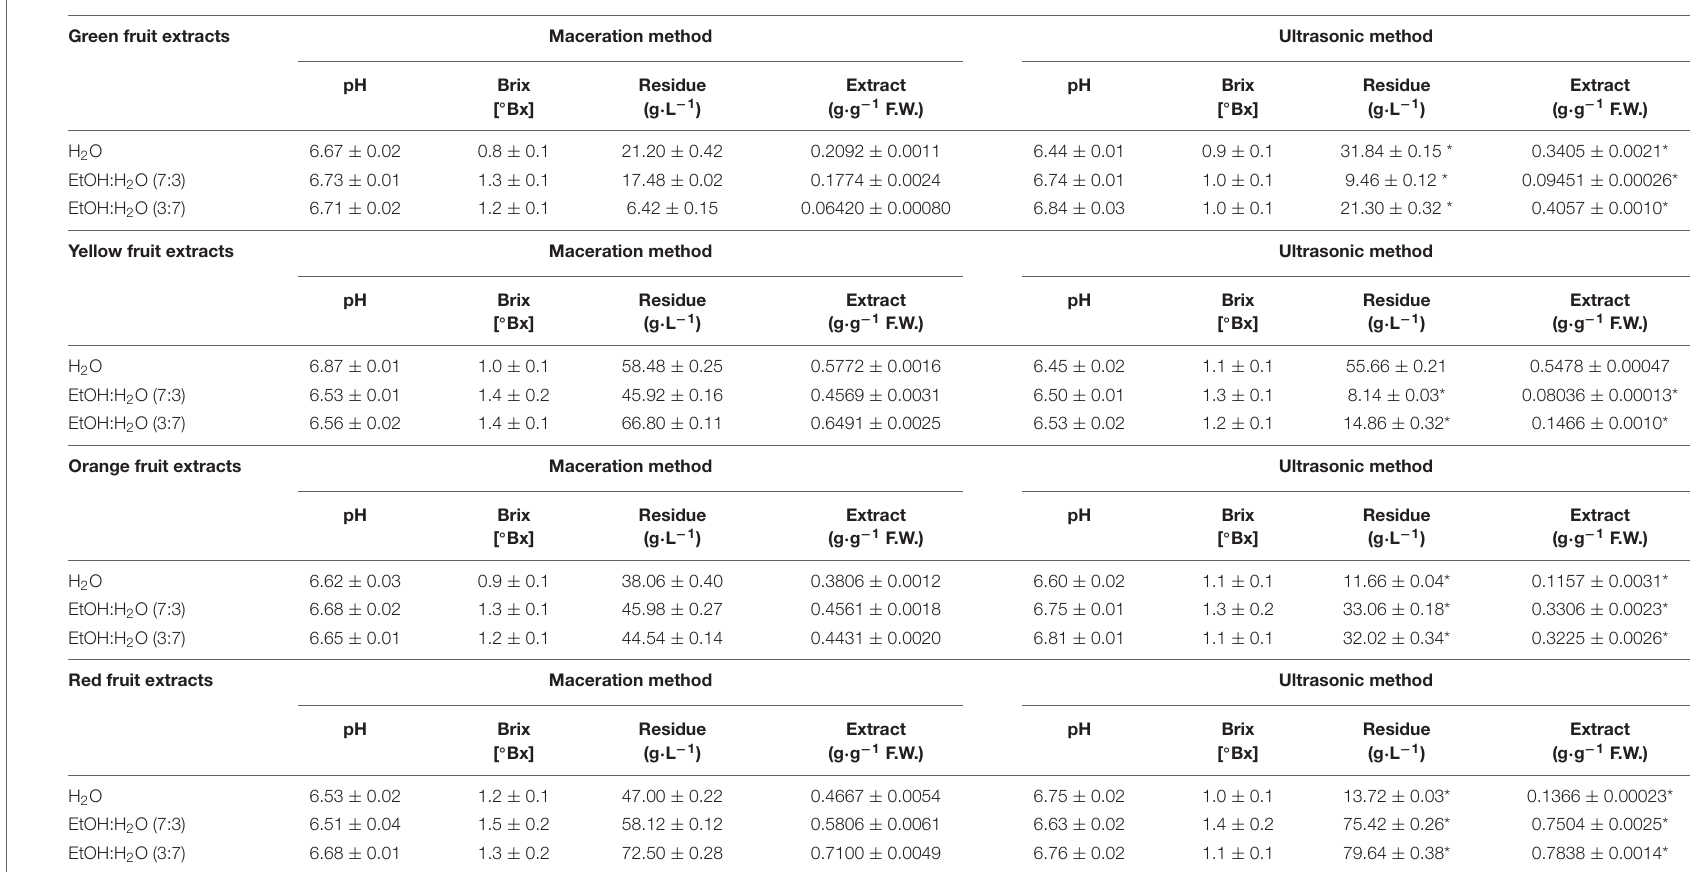
TABLE 2 | pH, specific gravity, dry residue, and extract value of the different A. unedo fruit extracts.